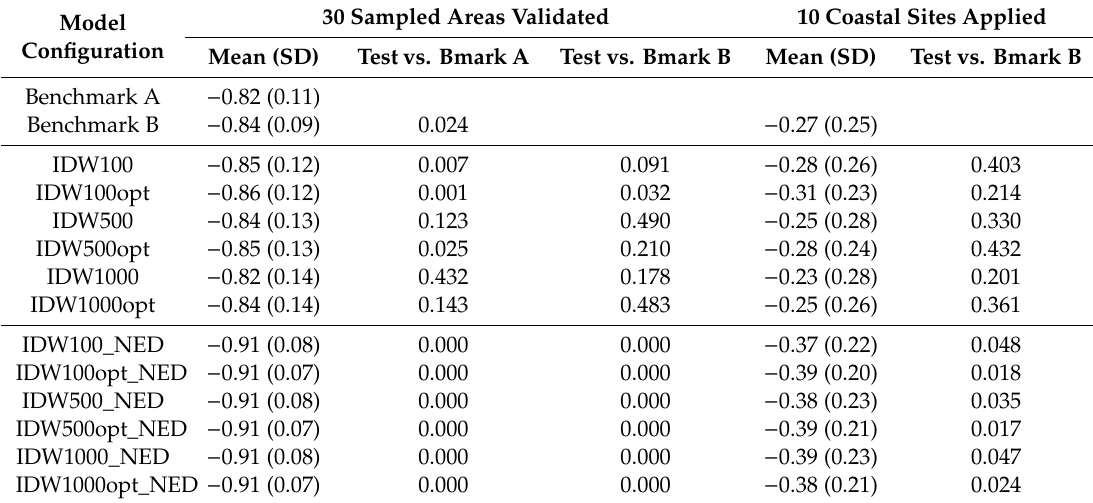
Table 3. F-ratio summary statistics of 30 sampled validation sites and 10 selected coastal sites.